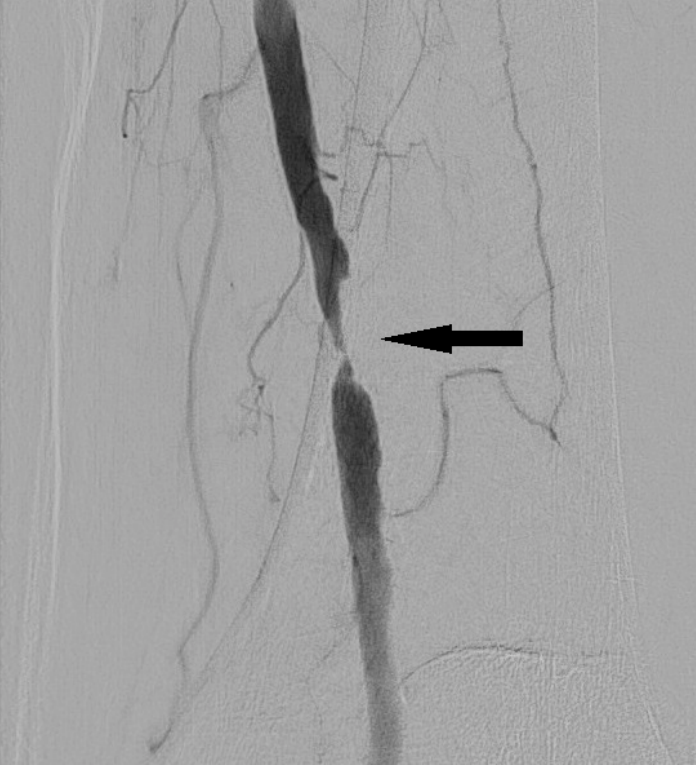
Figure 4. Chronic severe stenosis of distal femoral superficial artery (black arrow). Acute occlusion (Figure 6) is represented by a sudden blood flow blockage of one or more vessels, and can be due to an anomalous coagulation of blood after injury of the vessel’s intima layer, after catheter or guidewire passage, or after angioplasty balloon inflation. As the guidewire or diagnostic catheter or angioplasty balloon hits a thrombus or a mural plaque, or when a clot forms attached to the catheter and is afterwards dislodged, the consequences can be acute embolization and